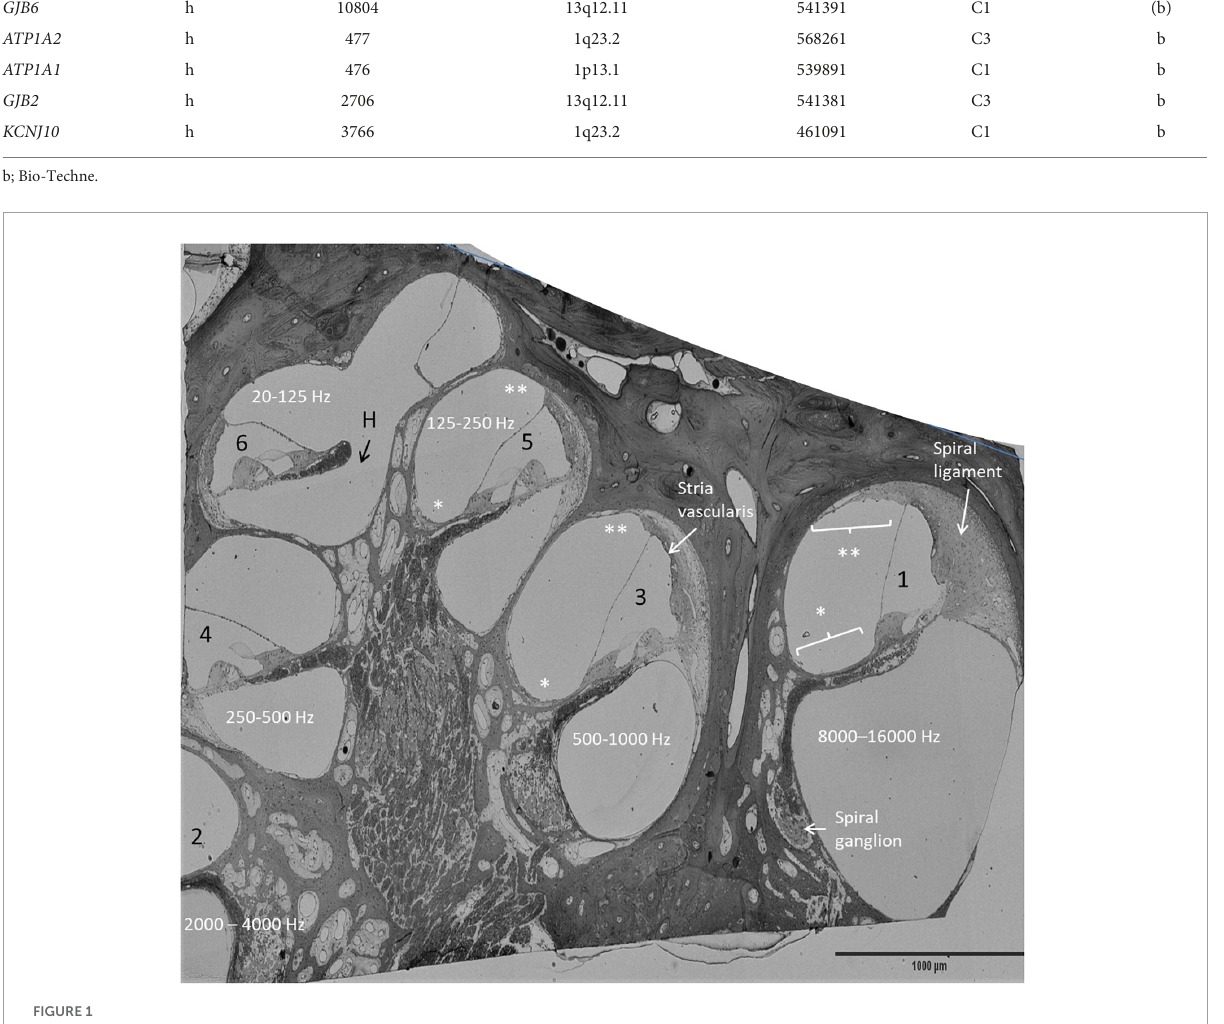
FIGURE1 Mid-modiolar, semi-thin section of the right HC. Frequency distribution was estimated by assessing the number of cochlear turns. The anatomy of the OC and the lateral wall vary along the cochlear axis. The spiral ligament is more prominent in the high frequency region